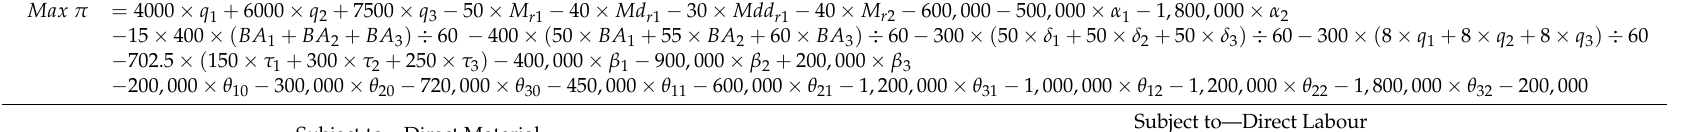
Table A2. The quality management decision model for capacity expansion without carbon tax (Scenario